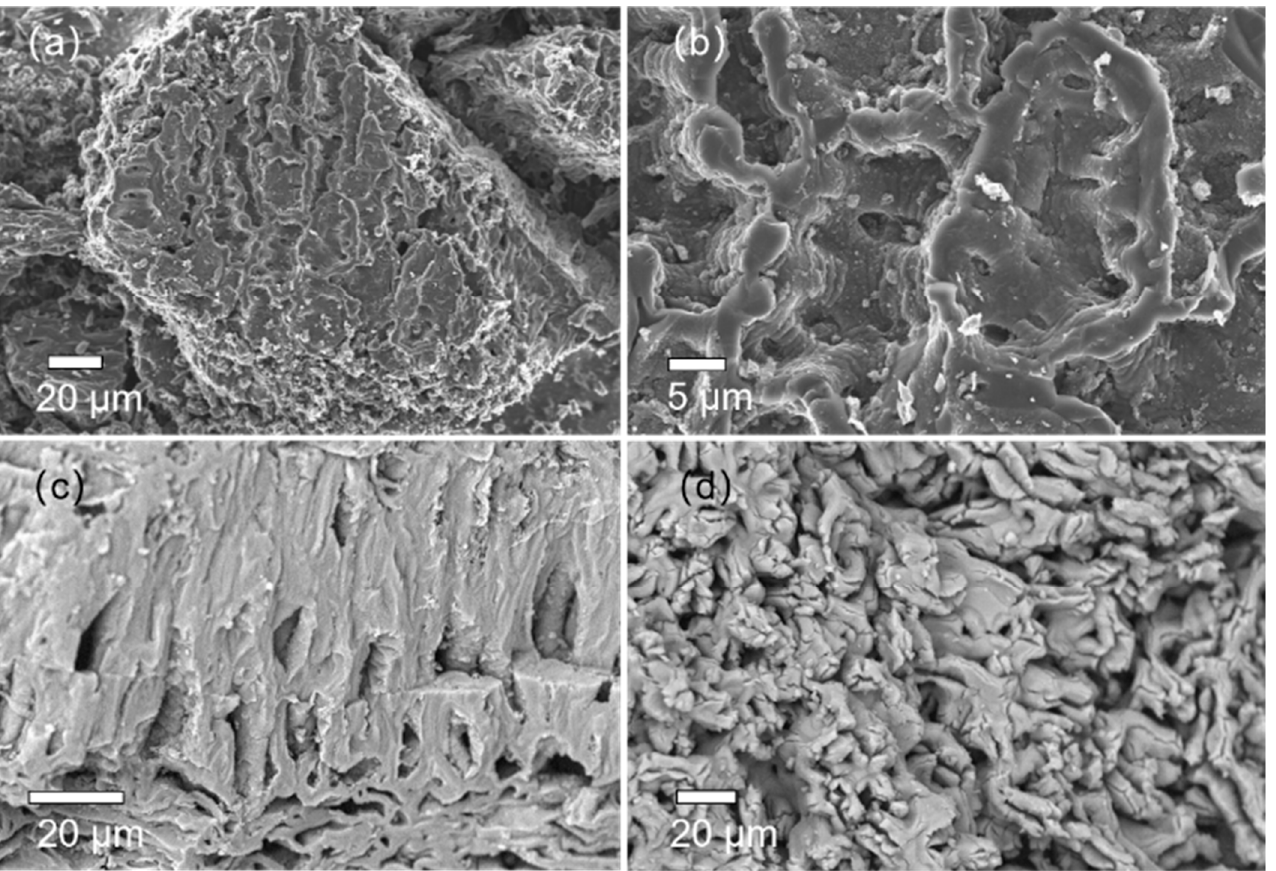
Figure 3. SEM images of ( a ) CN (500×), ( b ) CN (2000×), ( c ) MCS3 ‐ 1, and ( d )